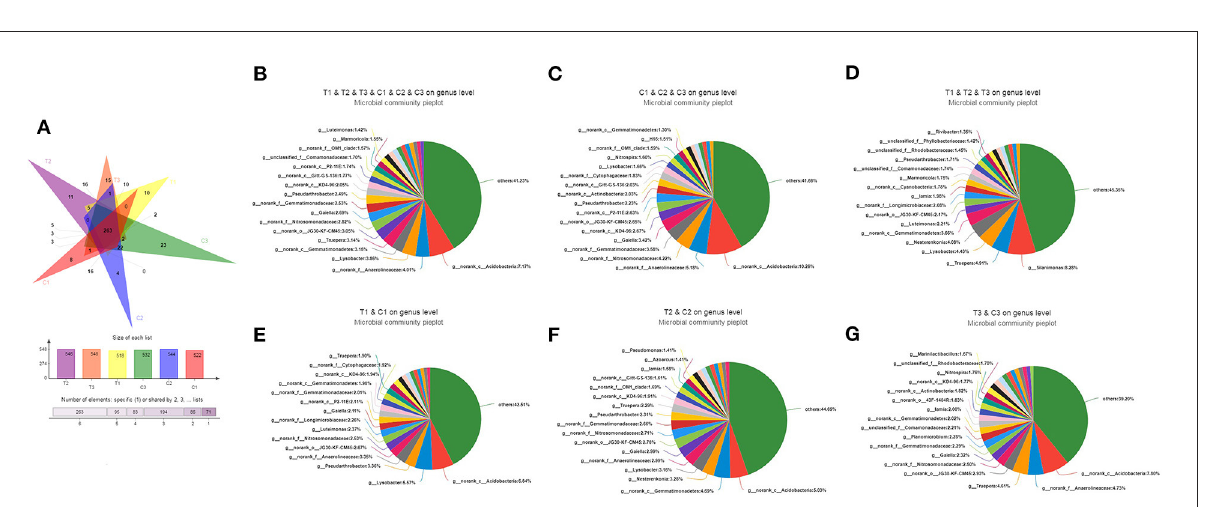
FIGURE3 Venn diagram evaluating the distribution of OTUs among the different treatments to reflect the differences and similarities of soil samples (A) . Pie diagrams were used to evaluate the distribution of genus among the C1, C2, C3, T1, T2, and T3 (B) , C1, C2, and C3 (C) , T1, T2, and T3 (D) , C1 and T1 (E) , C2 and T2 (F) , and C3 and T3 (G) , respectively. All data in the experiment represent three independent